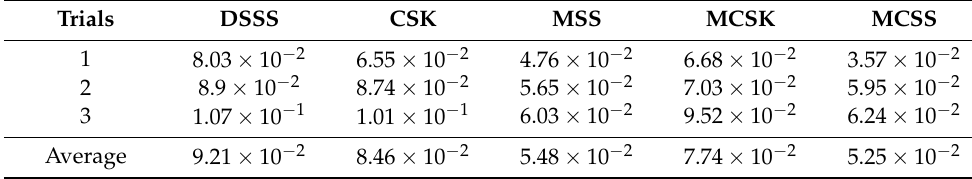
Table 5. Uncoded BER of signals without Doppler shift.